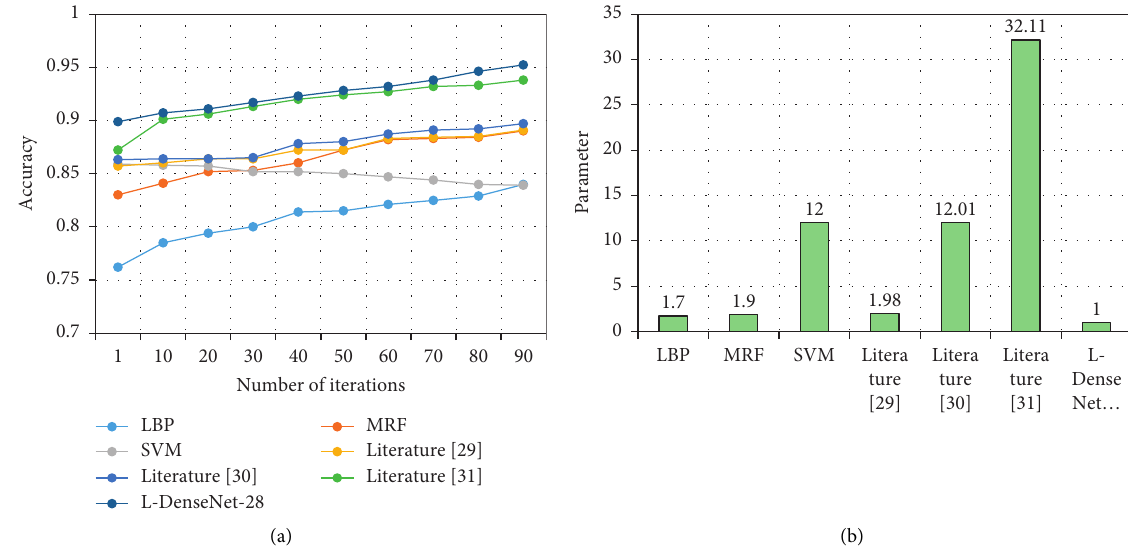
Figure 9: Comparison of classification accuracy and parameter values of different